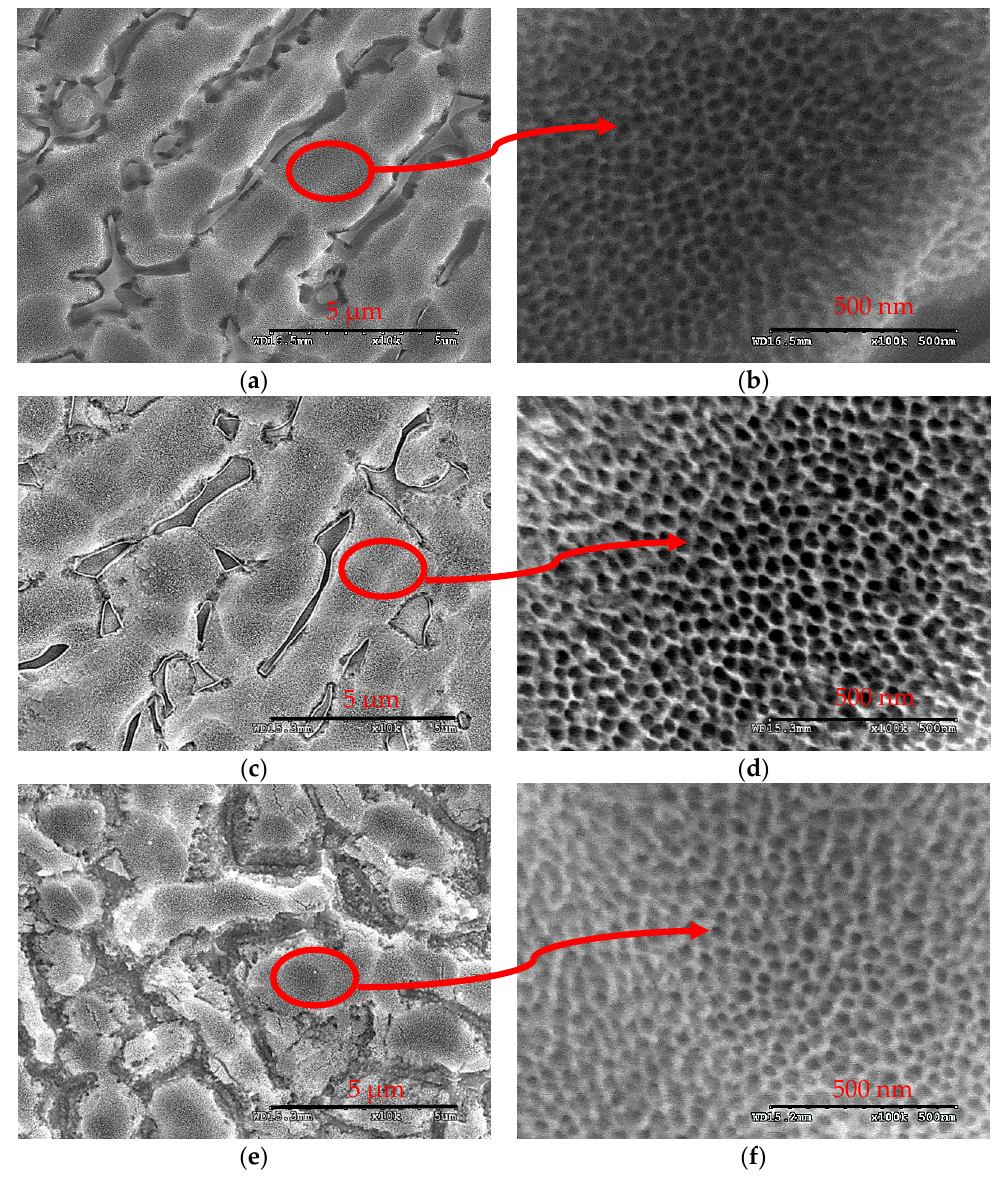
Figure 4. FESEM images of the samples after annealing for 1 h at ( a , b ) 200 °C, ( c , d ) 400 °C, and ( e , f ) 600 °C in an air atmosphere.